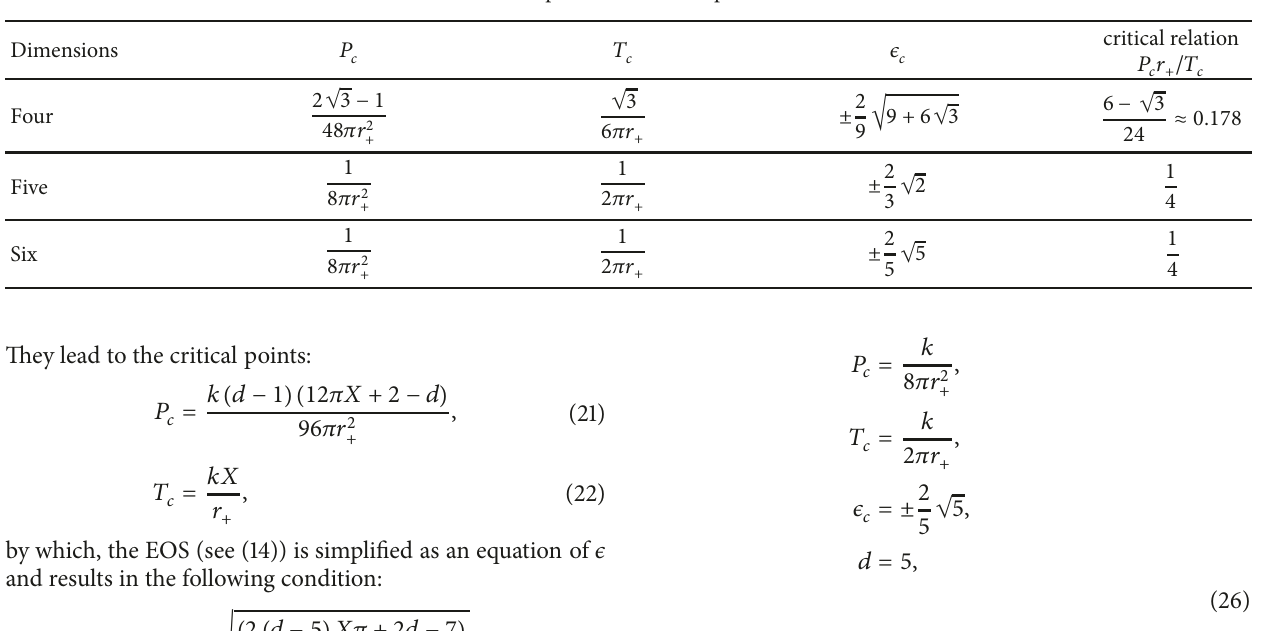
Table 1: The critical points of HL AdS spherical black